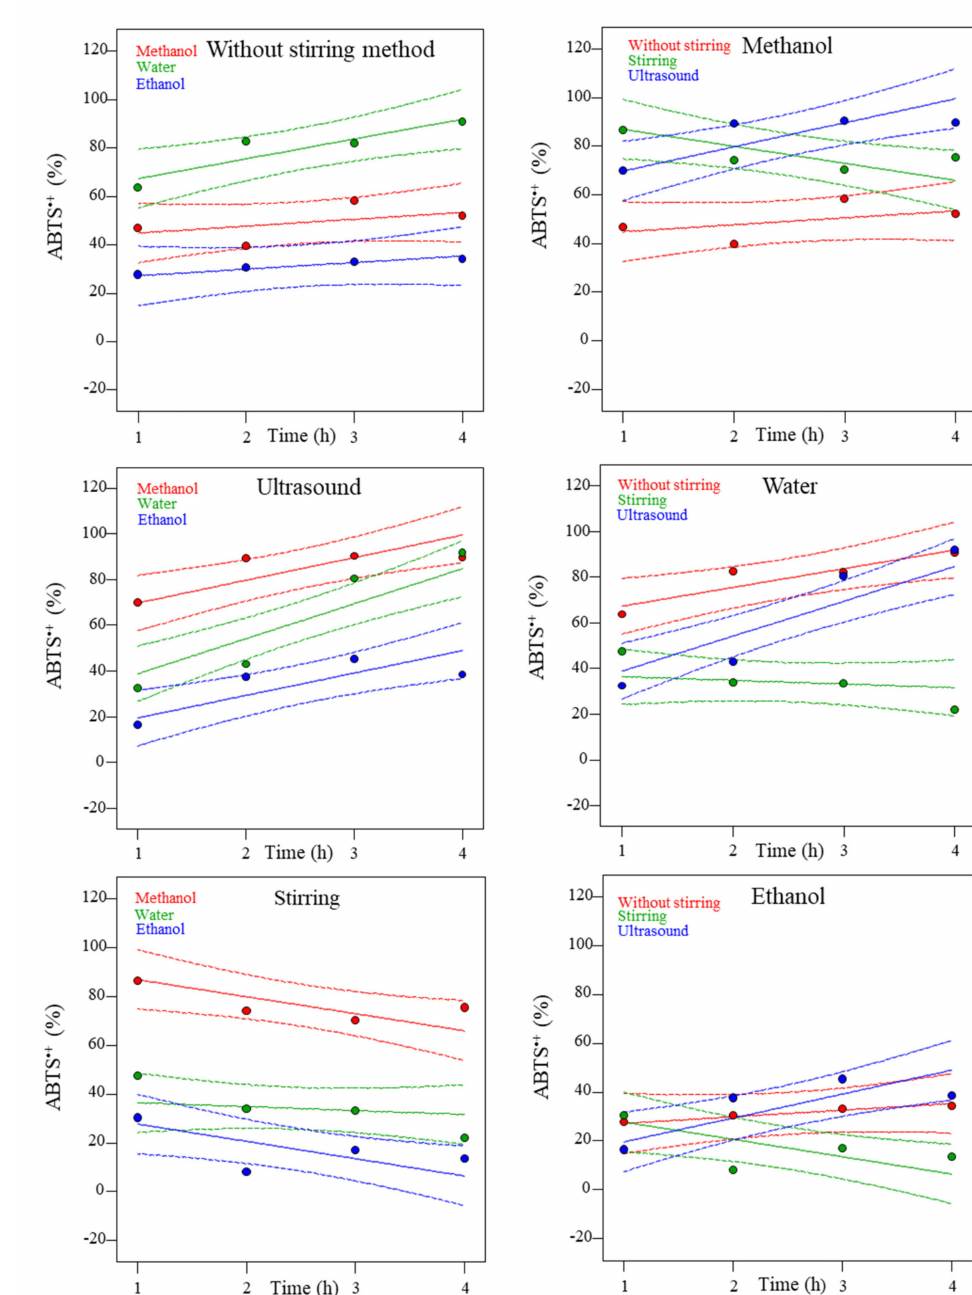
Figure 4. Experimental and predicted dependence of ABTS • + (2,2-azino-bis(3-etilbenzotiazolin)- 6-sulfonic acid) assay on time at different methods (without stirring, ultrasound, or stirring) and solvents (methanol, water, or ethanol). Dots are experimental results, dotted lines are 95% confidence bands, and solid lines are the predicted